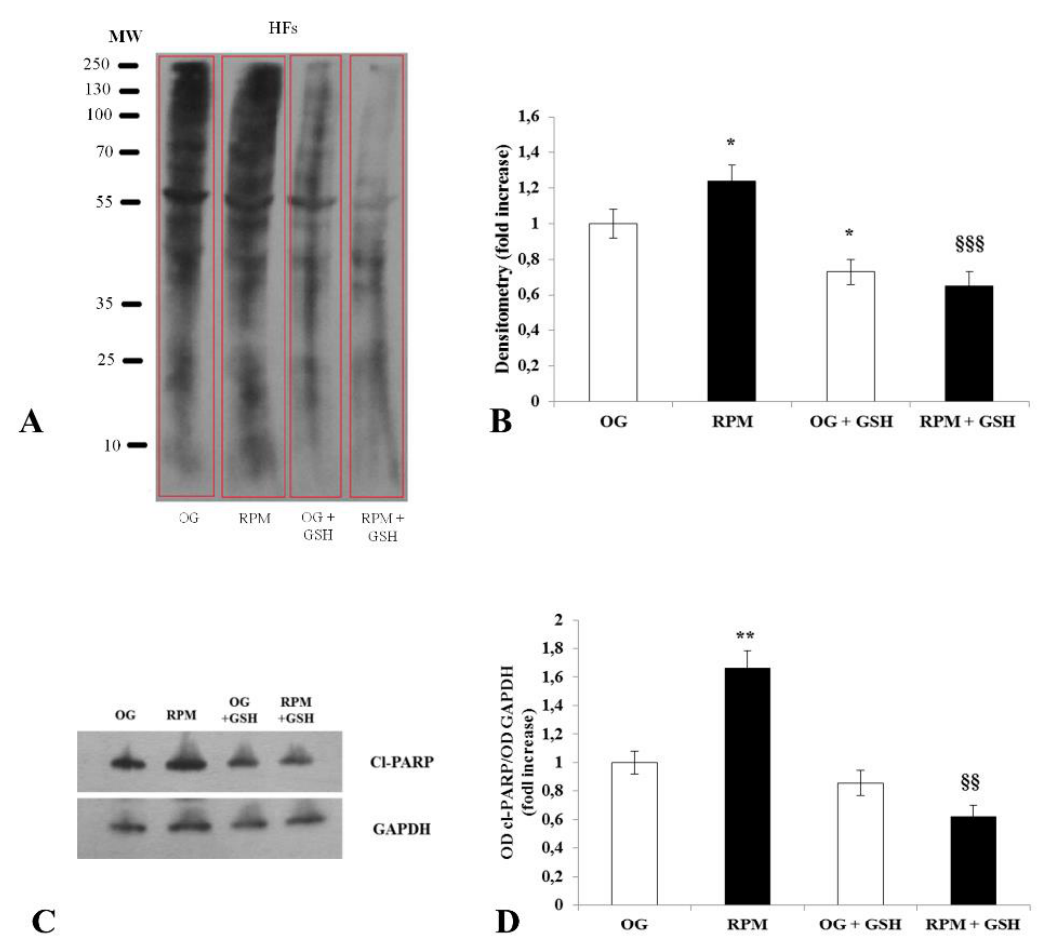
Figure 2. Oxidative stress in human dermal fibroblasts after being exposed to simulated microgravity for 24 h. ( A ) Immunoblots for total carbonylated proteins from human fibroblasts exposed or unexposed to the RPM, treated or not with the antioxidant glutathione GSH. ( B ) Band densitometry analysis for total carbonylated proteins. Values are expressed as a fold increase of OG control, where each column represents the mean value ± SD of four independent experiments. SD is depicted as vertical bars. * p < 0.05 versus OG control; §§§ p < 0.001 versus RPM by ANOVA followed by Bonferroni post-test. ( C ) Representative Western blot analysis panel and ( D ) immunoblot bar charts showing the expression of Cl-PARP in human dermal fibroblasts exposed or unexposed to simulated microgravity, treated or untreated by GSH. Columns represent the densitometric quantification of optical density (OD) of a Cl-PARP signal normalized with the OD values of GAPHD as a loading control. Values are expressed as a fold increase of OG control. Each column represents the mean value ± SD of three independent experiments, where SD is depicted as vertical bars. ** p < 0.01 versus OG control; §§ p < 0.01 versus RPM by ANOVA followed by Bonferroni post-test.